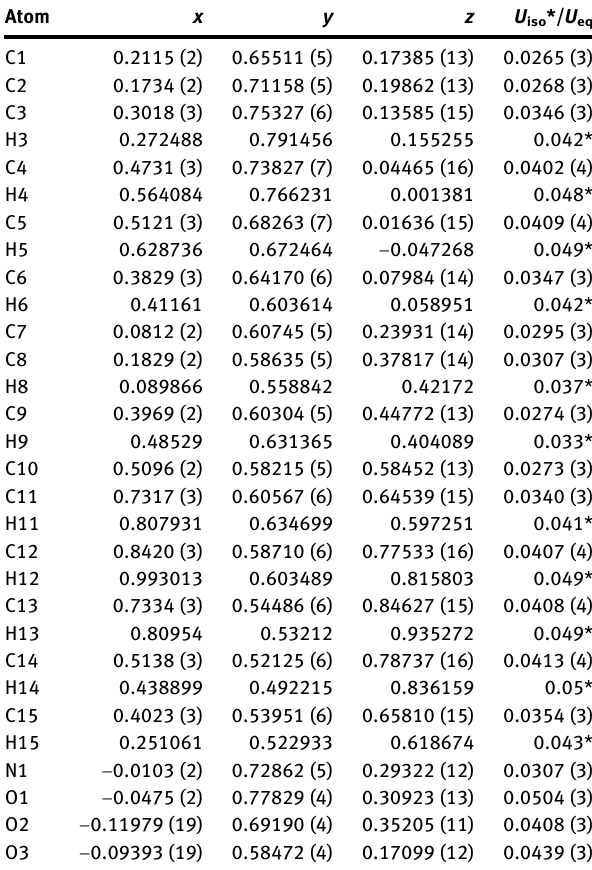
Table  : Fractional atomic coordinates and isotropic or equivalent isotropic displacement parameters (Å 